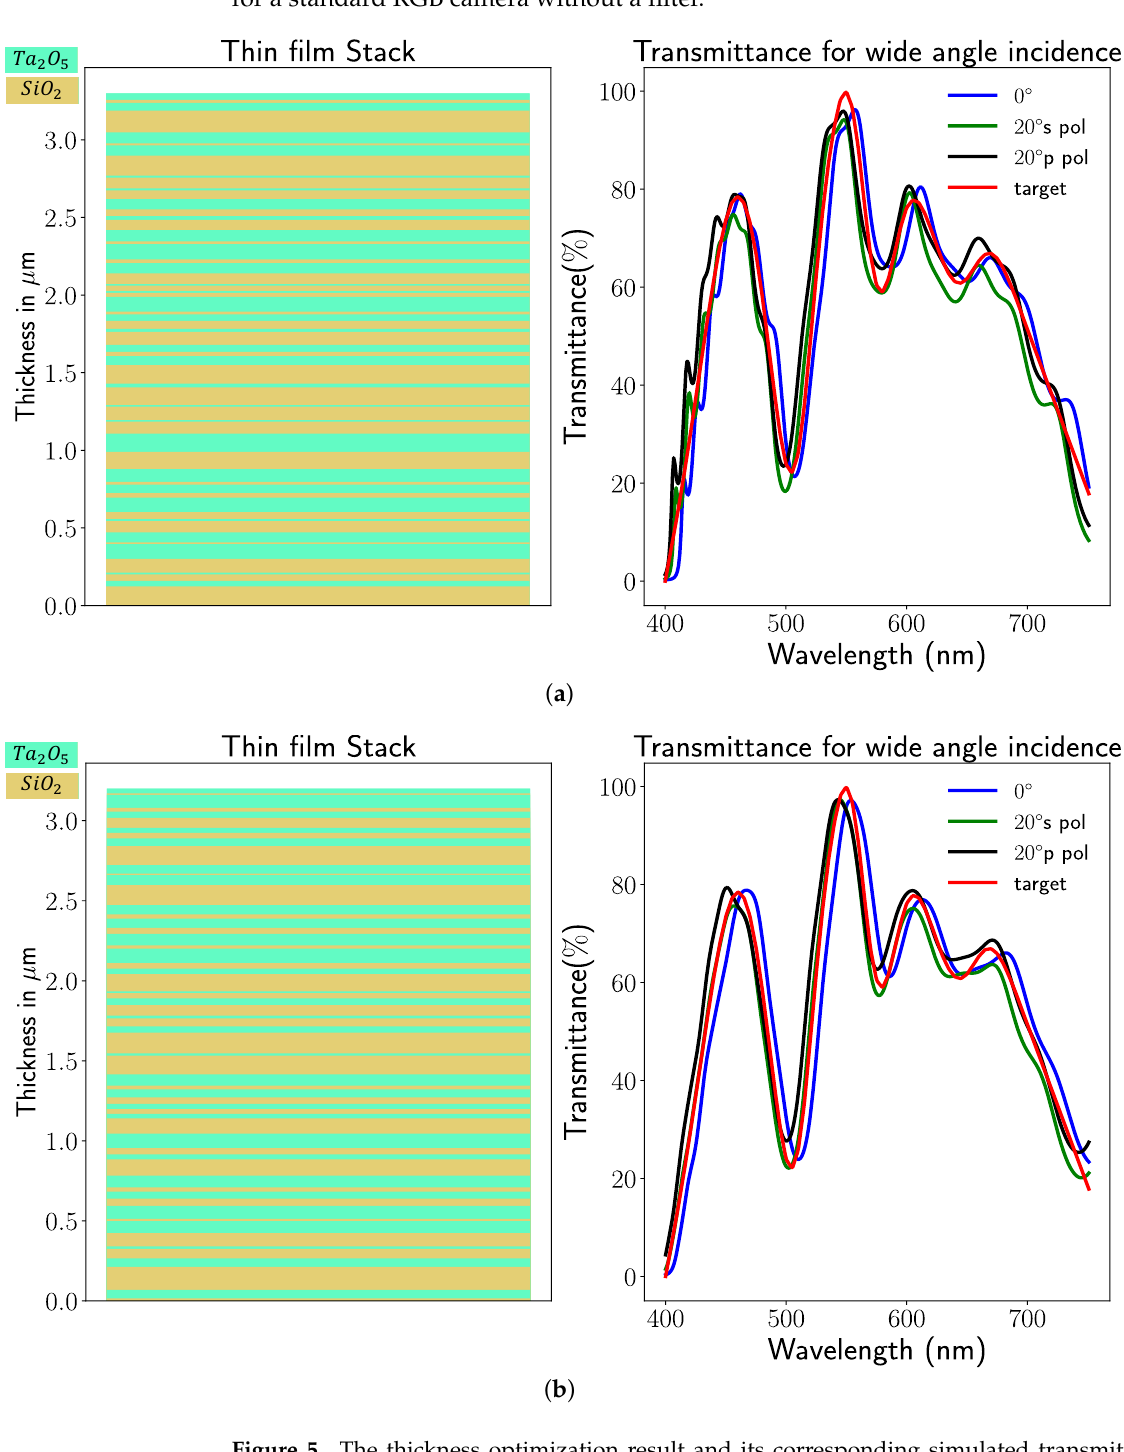
Figure 5. The thickness optimization result and its corresponding simulated transmittance for ( a ) merit function 1 and ( b ) merit function